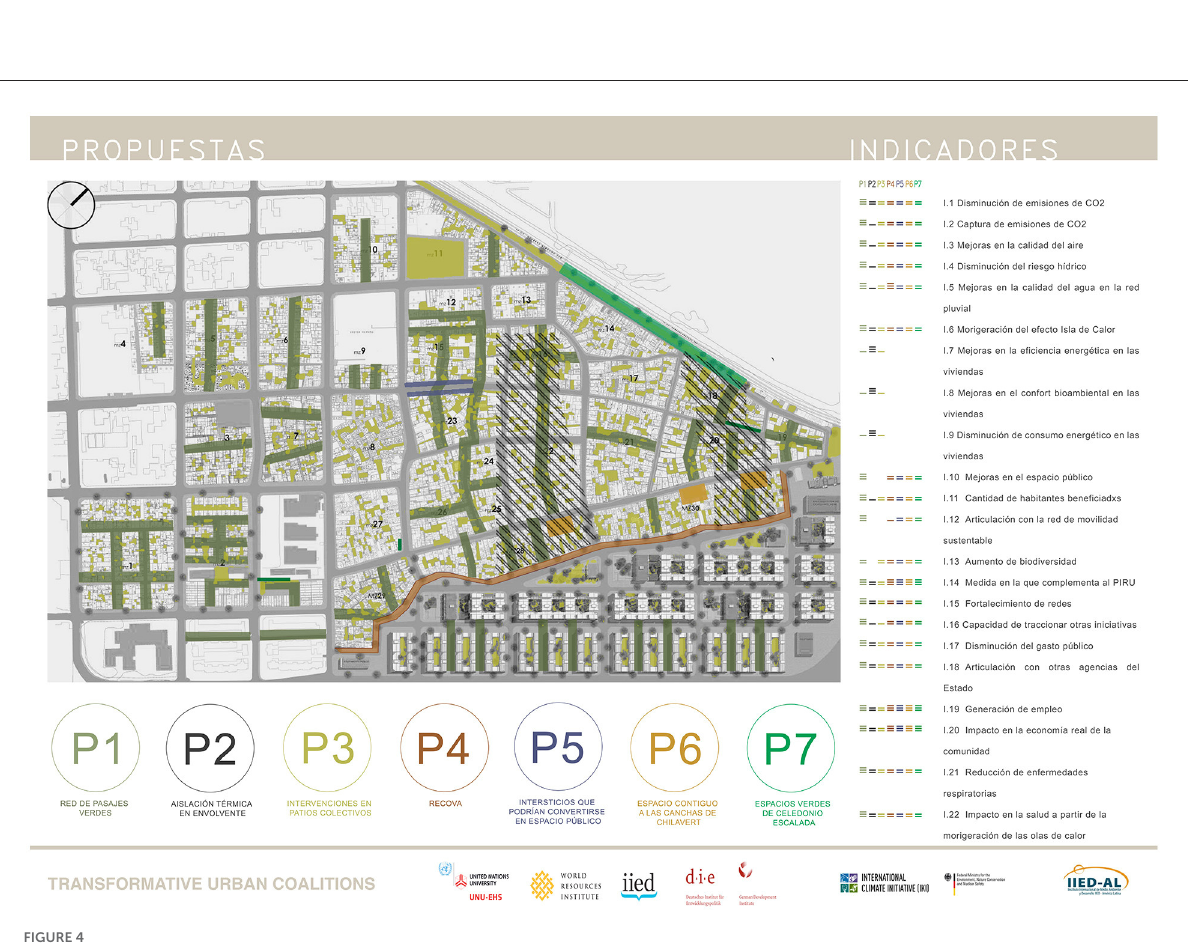
FIGURE4 Possible pilot projects with indicators. Source TUC